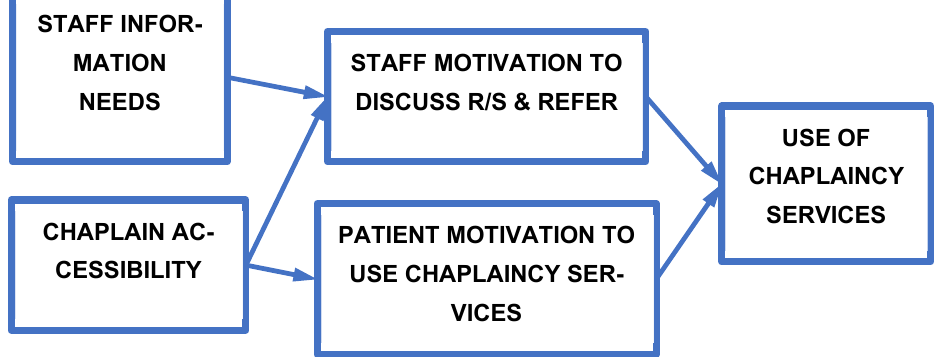
Figure 1. Conceptual framework of staff and patient motivation to engage in religious/spiritual discussions and Use Chaplaincy Services. The figure identifies the four themes identified and their relationship to the outcome of using chaplaincy services by veteran patients and/or service providers in the Substance Use Specialty Care outpatient clinics of the VA Connecticut Healthcare System.